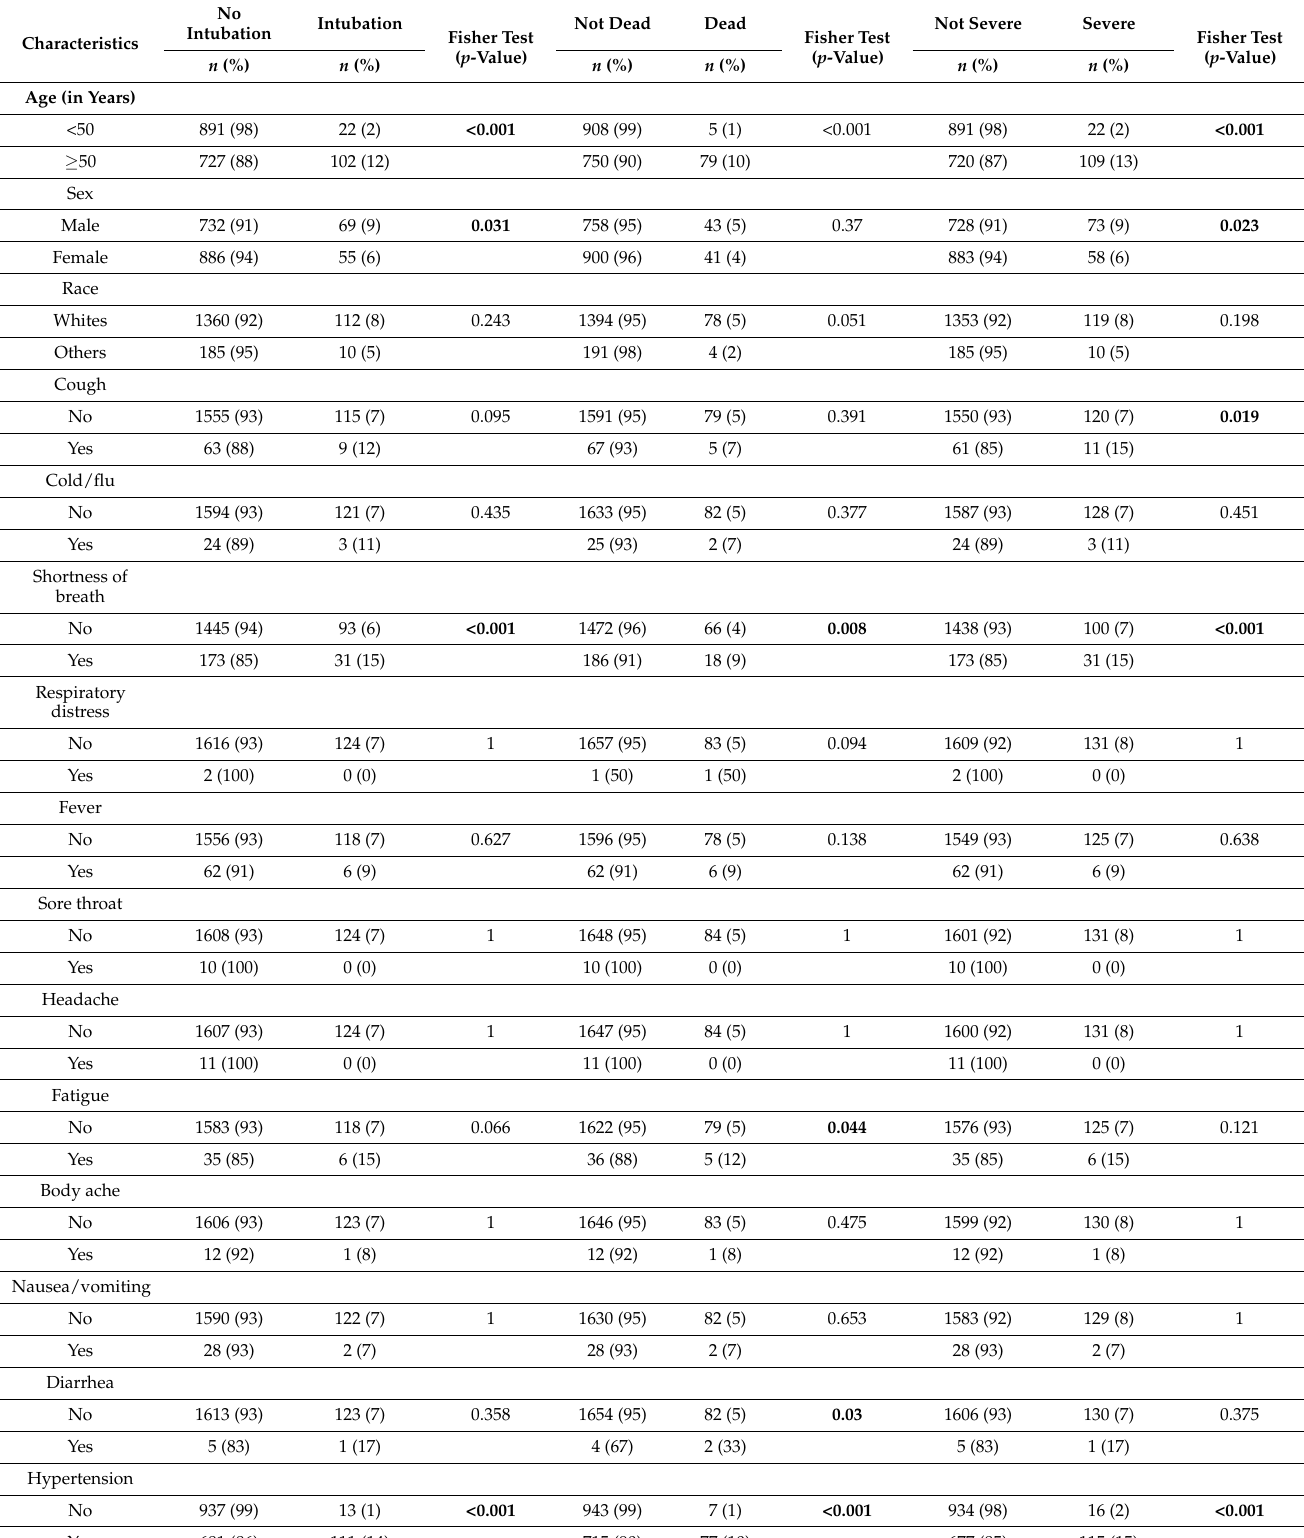
Table 2. Intubation, severity, and outcomes for different